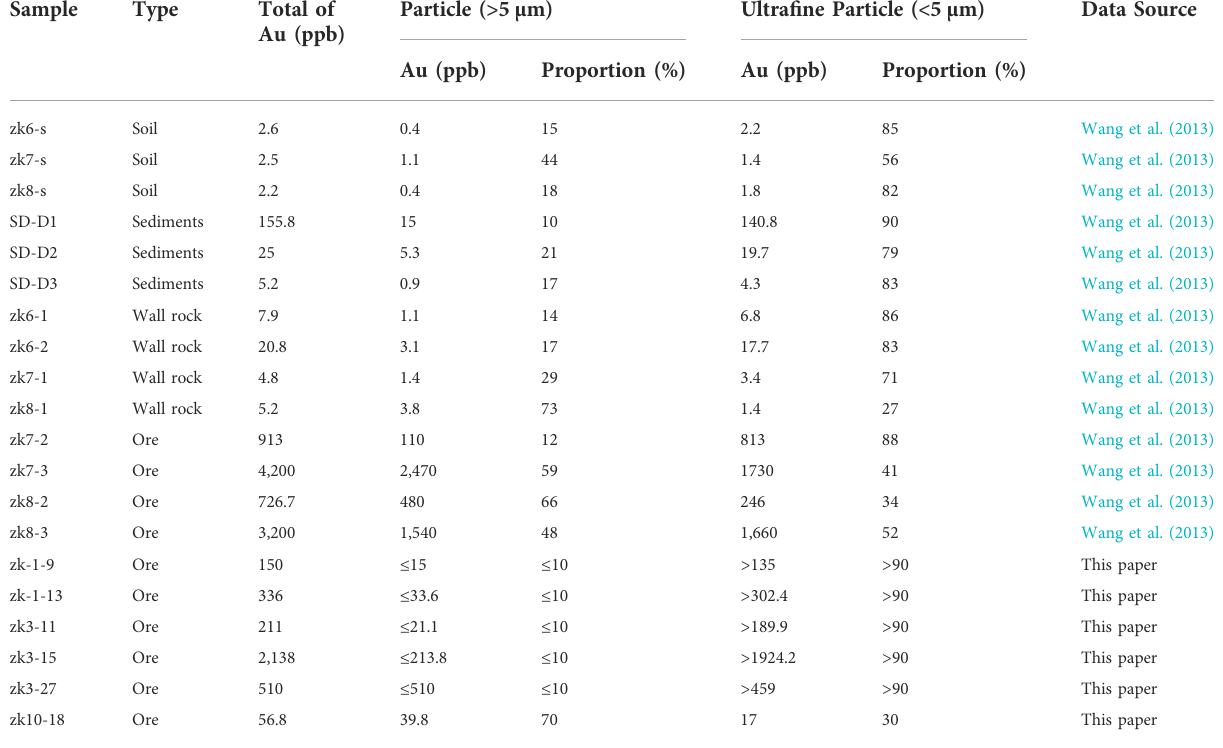
TABLE 2 Proportion of gold particle and ultra fi ne gold in Jiaodong gold deposit.